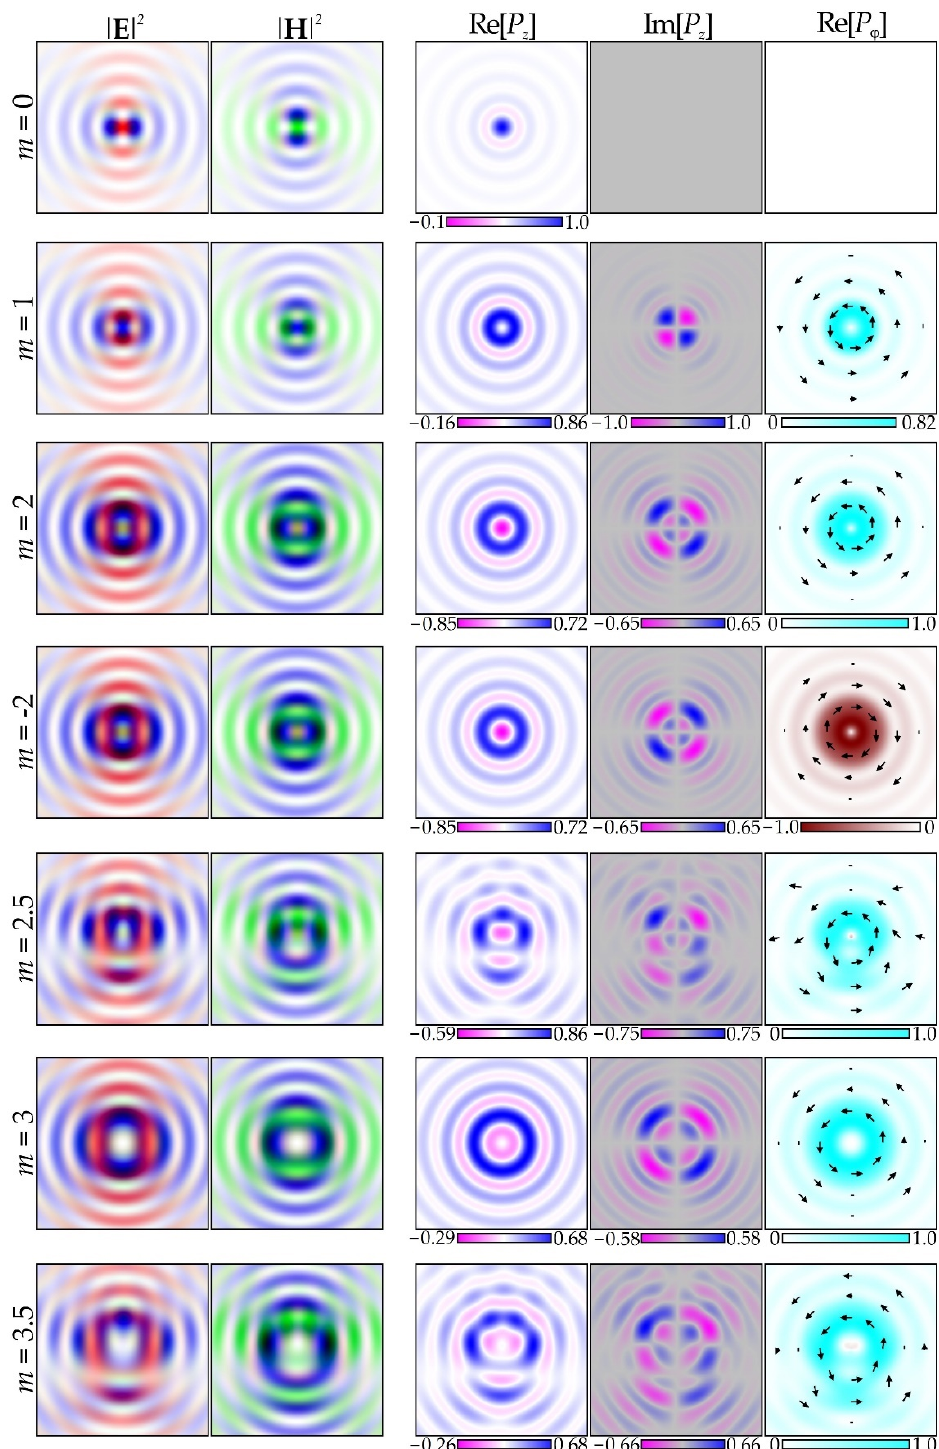
Figure 2. Simulation results for classic SPPs exp( im φ ) of various orders m (red color − for x -compo- nents, green color—for y -components, and blue color—for z -components). The distributions in the focal plane with a size of 4 λ × 4 λ are shown.